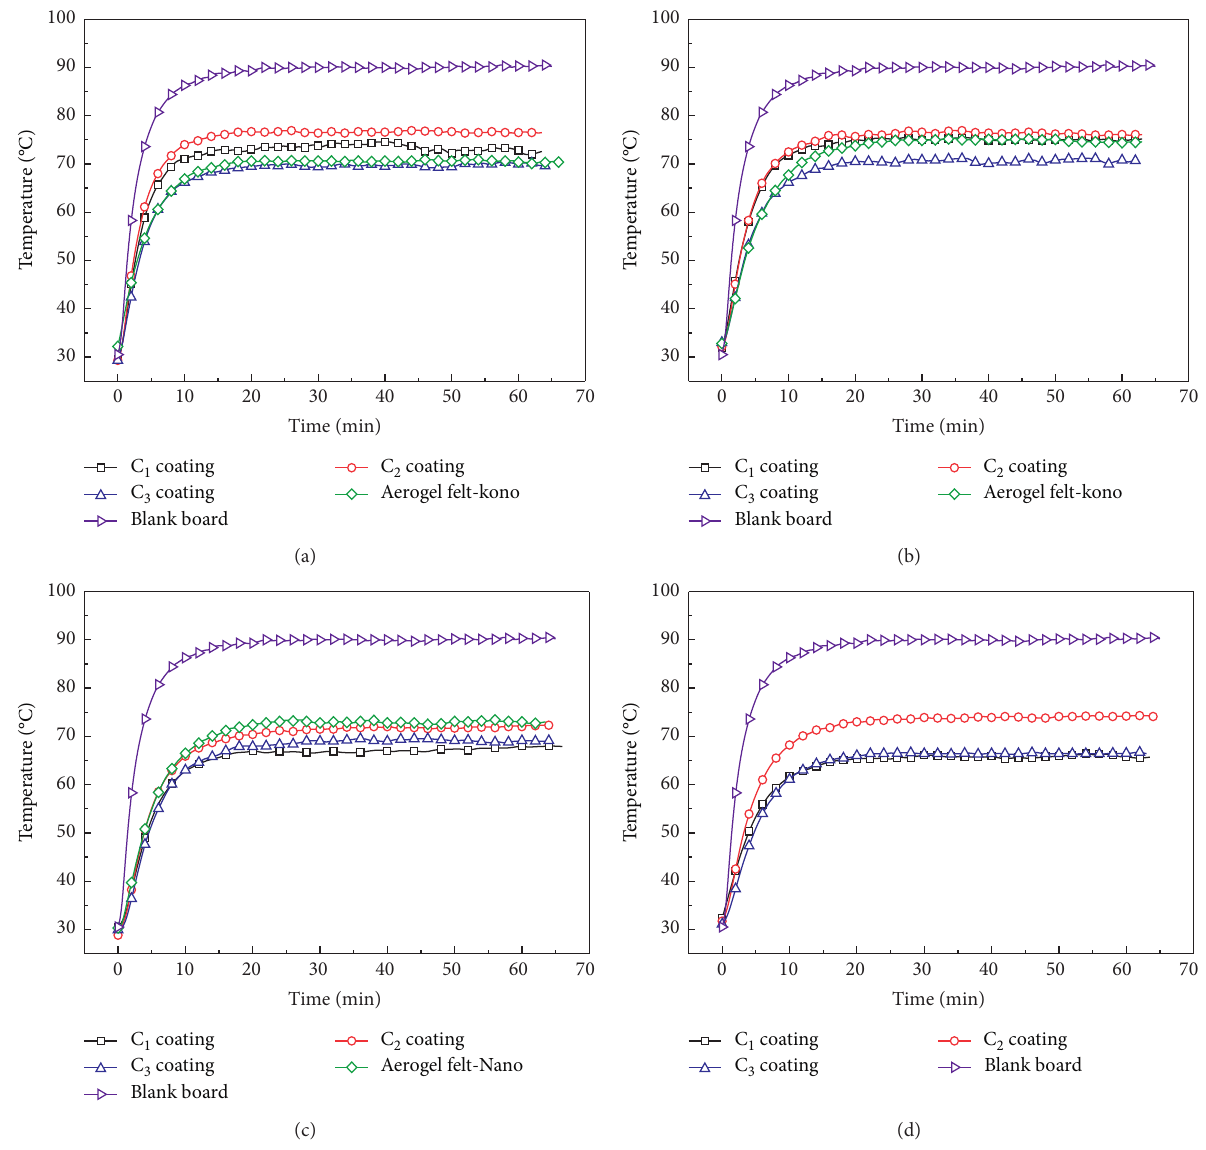
Figure 9: Insulation properties of the different materials. (a) 1 mm-150 ° C. (b) 2mm-150 ° C. (c) 3 mm-150 ° C. (d) 4mm-150 ° C.